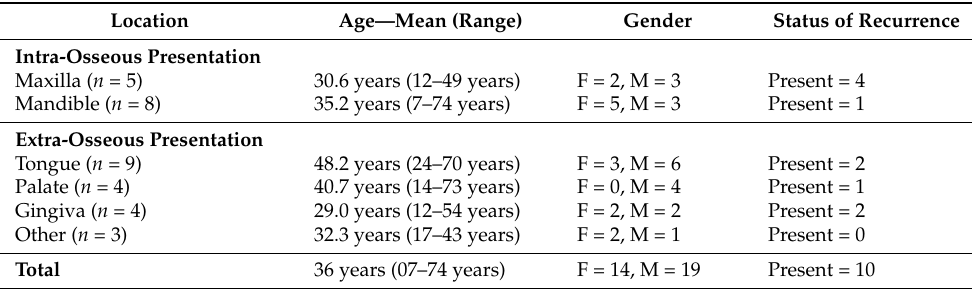
Table 3. Literature review-based comparison of clinical presentations of low-grade myofibroblastic sarcoma depending on the site of